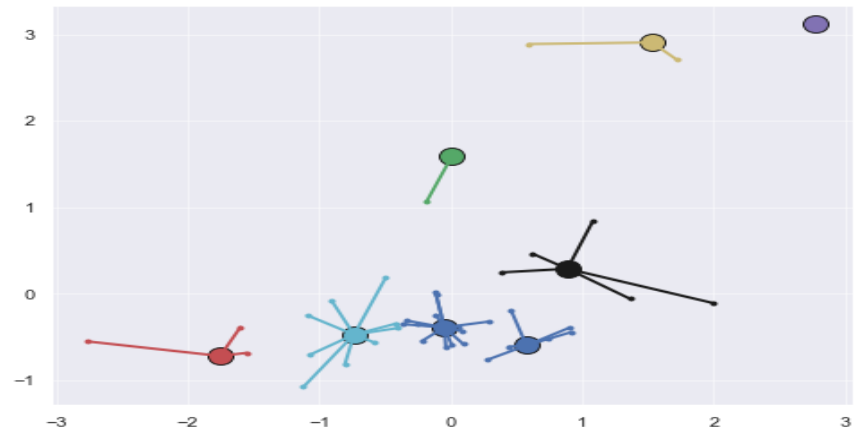
Figure 10. Estimation of the number of clusters using the affinity propagation Clustering